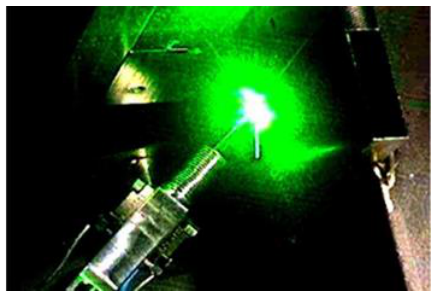
Figure 1. Underwater laser peening.